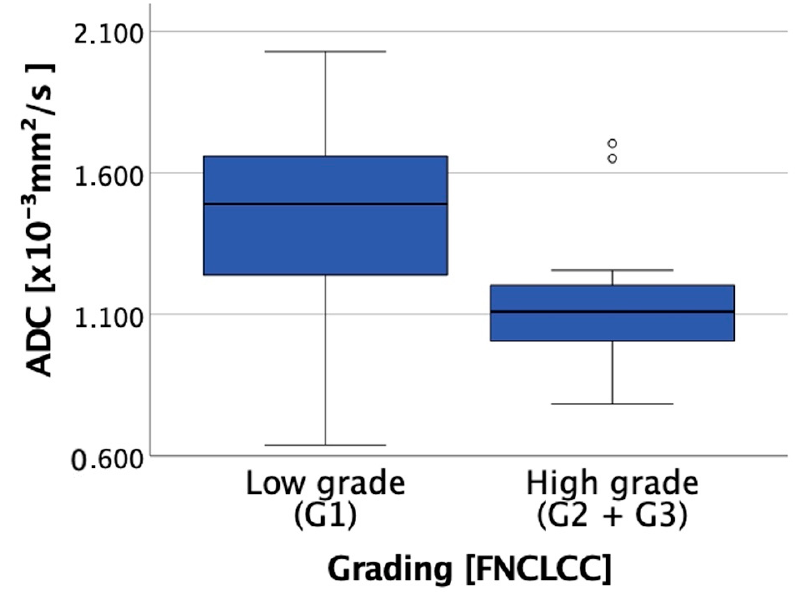
Figure 3. Boxplot showing the correlation between ADC and grading (low grade (Grade (G) 1) vs. high grade (G2 and G3)).